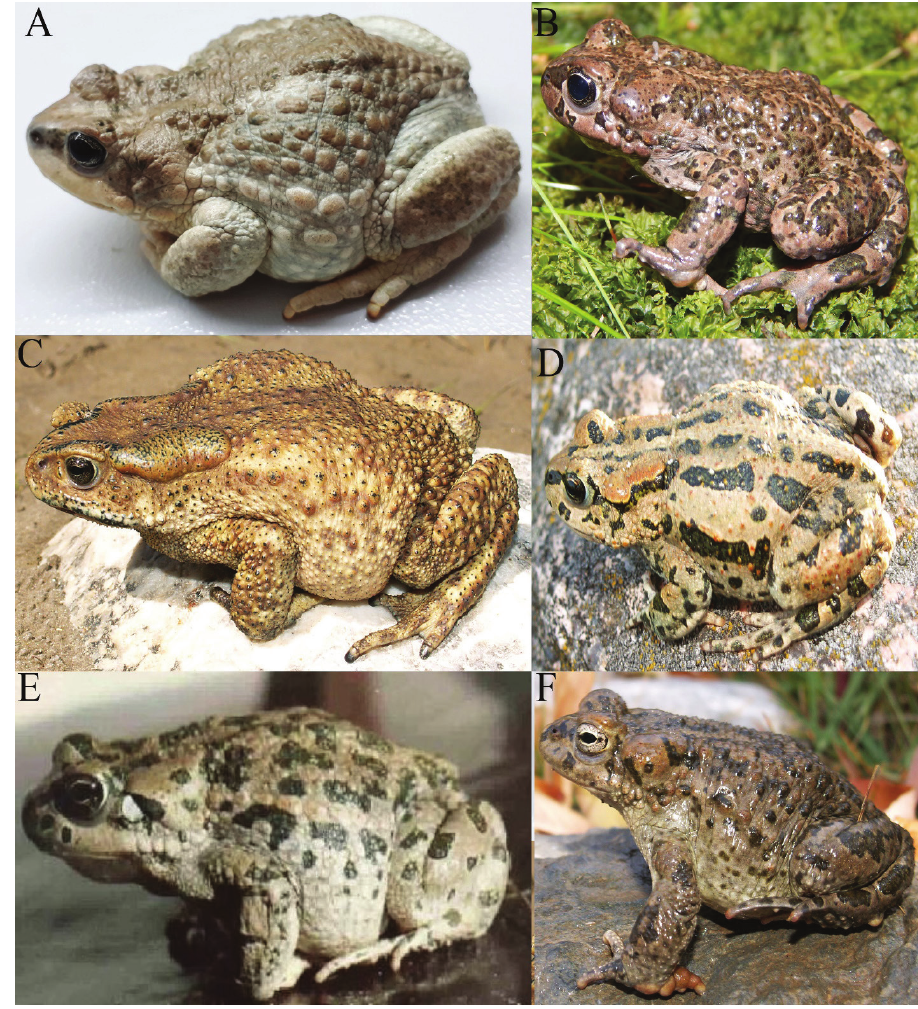
Figure 1. A Iranian Toad ( Bufotes surdus ) B Batura Toad ( Bufotes baturae ) C Himalayan Toad ( Dut- taphrynus himalayanus ) D Ladakh Toad ( Bufotes latastii ) E Baloch Green Toad ( Bufotes zugmayeri ) F Swat Green Toad ( Bufotes pseudoraddei ). Photographers: Dr Spartak Litvinchuk ( A–D , F ); Muhammad Sharif Khan ( E